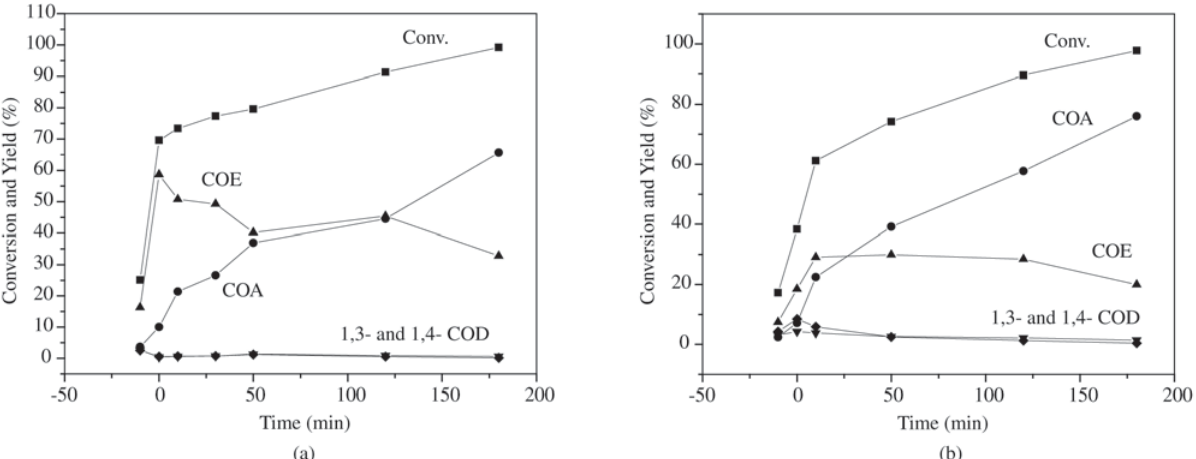
Figure 7. Catalytic hydrogenation of 1,5-cyclooctadiene in the presence of (a) catalyst RuSn/AC exposed to air and reduced with H 200 °C; (b) catalyst RuSn/AC treated at 500 °C with H within the time taken to reach the reaction temperature, 80